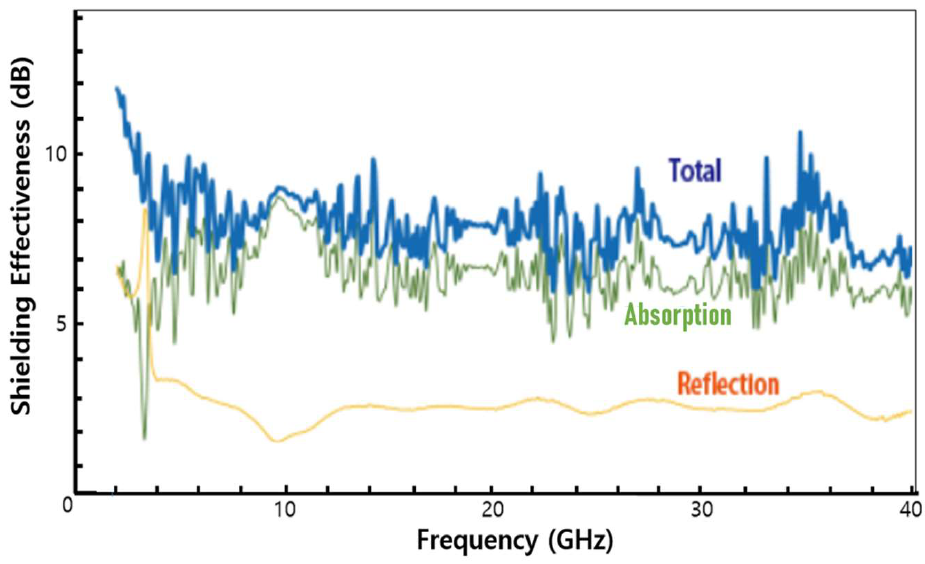
Figure 8. Total SE values, the SE values for the reflection loss, and the SE values for the absorption loss of the des-HF manufactured by 5 wt% sample J-incorporated carbon paste.